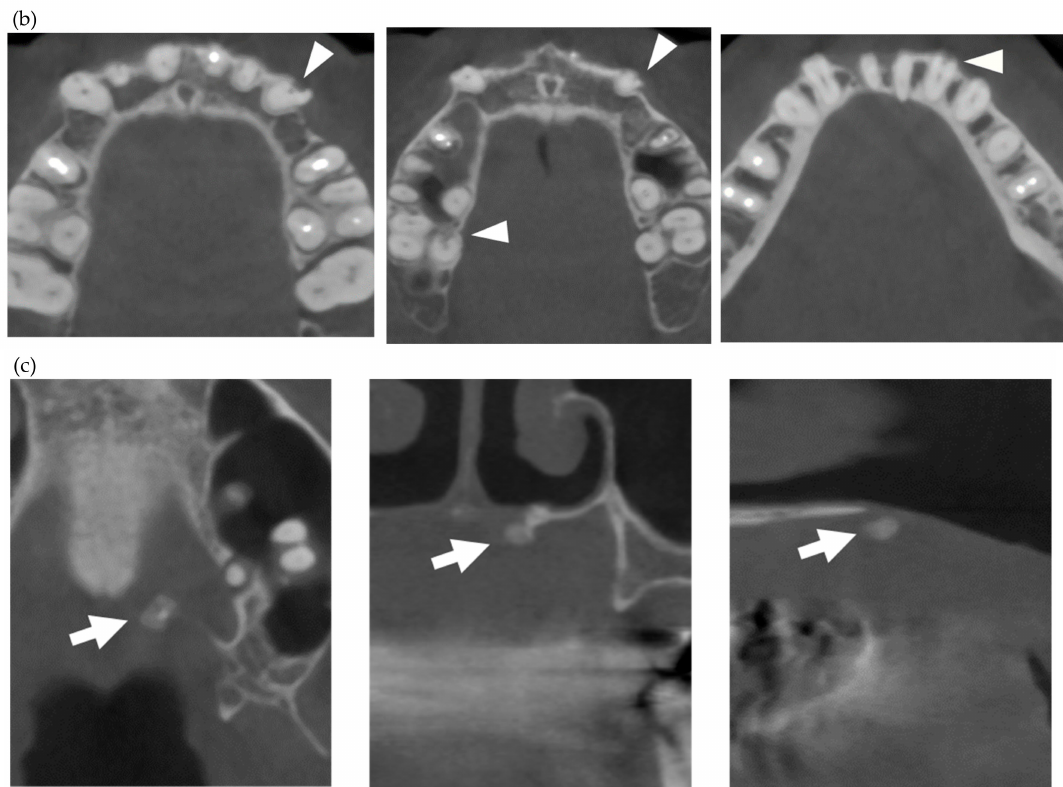
Figure 3. Multiple external root resorption and calcinosis at the oral region in pt. 4. A dental X-ray photo and CBCT image of teeth and the deposition of calcinosis at the palatal site ( a – c ). The white arrowhead represents root resorption, the black arrowhead, PDL space widening, and the white arrow, calcinosis, while the black arrow shows a failure to close the space with orthodontic